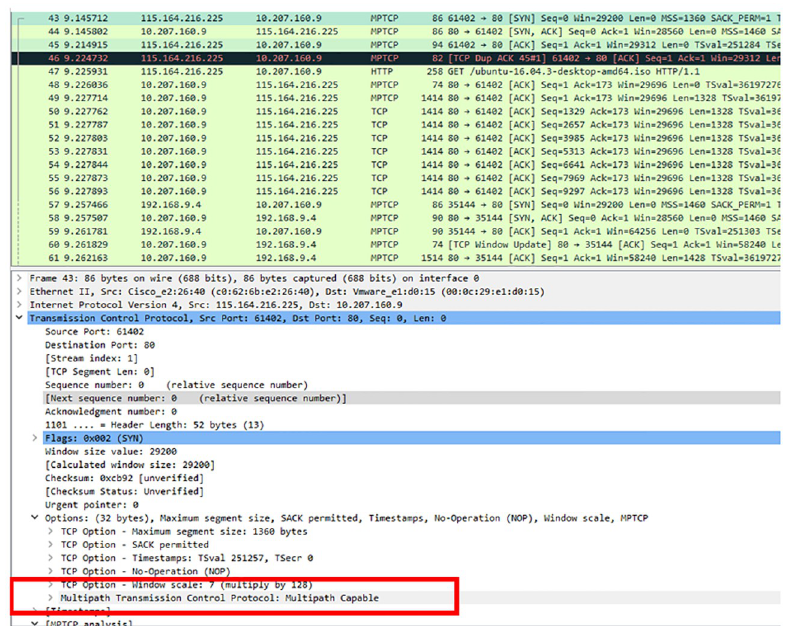
Fig 24. MPTCP capable message exchange between the mobile device and server.